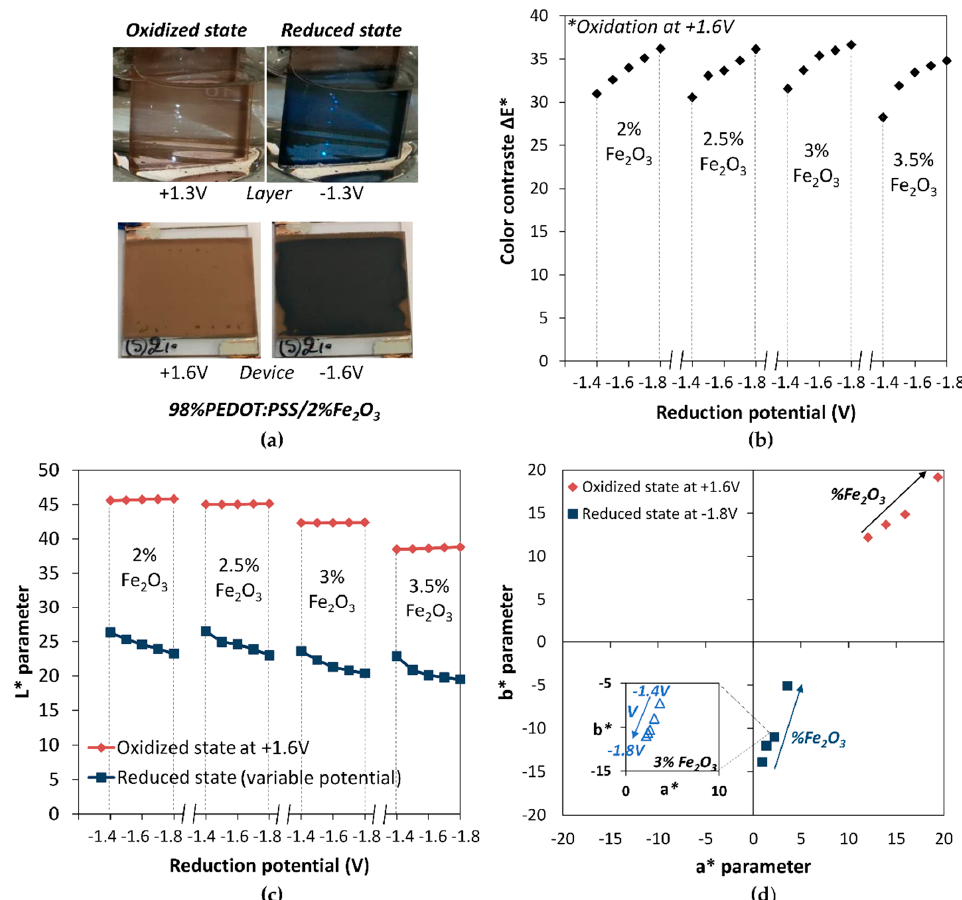
Figure 9. This figure shows the tuning of the L*a*b* parameters by adjusting the Fe 2 O 3 content or the reduction voltage. ( a ) Image of the oxidized and reduced state of a 98%PEDOT:PSS/2%Fe 2 O 3 thin layer and display, changing from red to blue color. ( b ) L* parameter as a function of the reduction voltage for different Fe 2 O 3 contents. ( c ) Tuning of a*b* parameters by increasing Fe 2 O 3 content for oxidized state at 1.6 V and reduced state at − 1.8 V ( d ); inset shows the tuning of the blue shade by varying the reduction voltage.